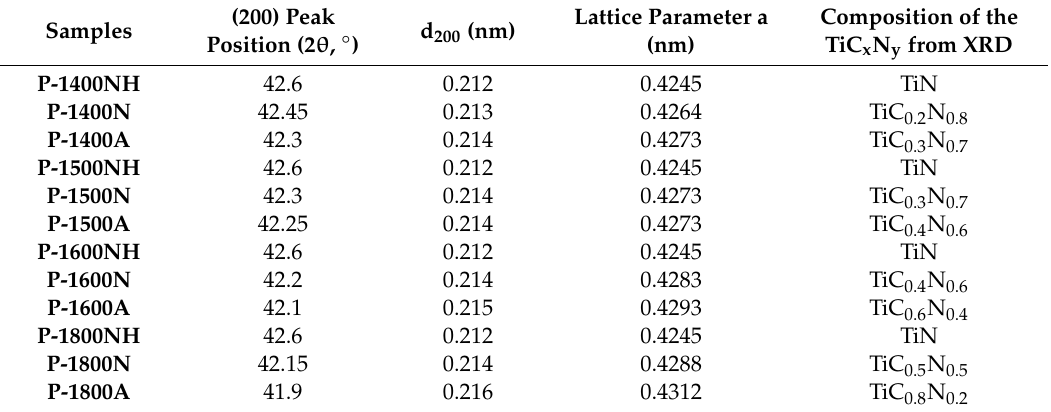
Table 1. Structural parameters measured based on XRD pattern of nanocomposite